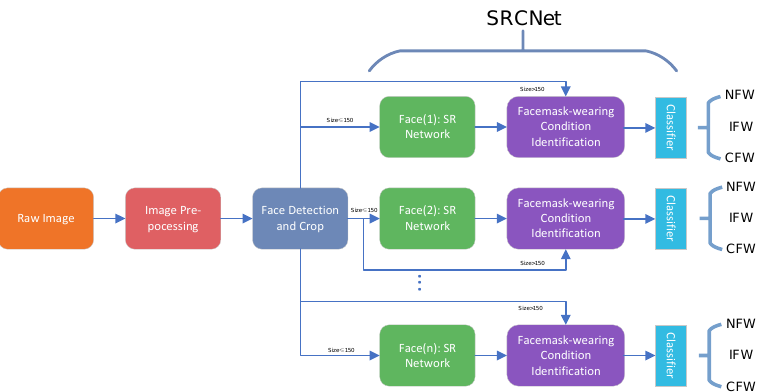
Figure 1. Diagram of the proposed algorithm. Face (n) is the n th cropped facial image. Listed super- resolution (SR) networks and facemask-wearing identification networks are to show that the SR and facemask-wearing condition identification process can both be executed in parallel for a single image with many faces. However, only one SR network and one facemask-wearing identification network are used in the proposed method. NFW = no facemask-wearing, IFW = incorrect facemask-wearing, CFW = correct facemask-wearing.